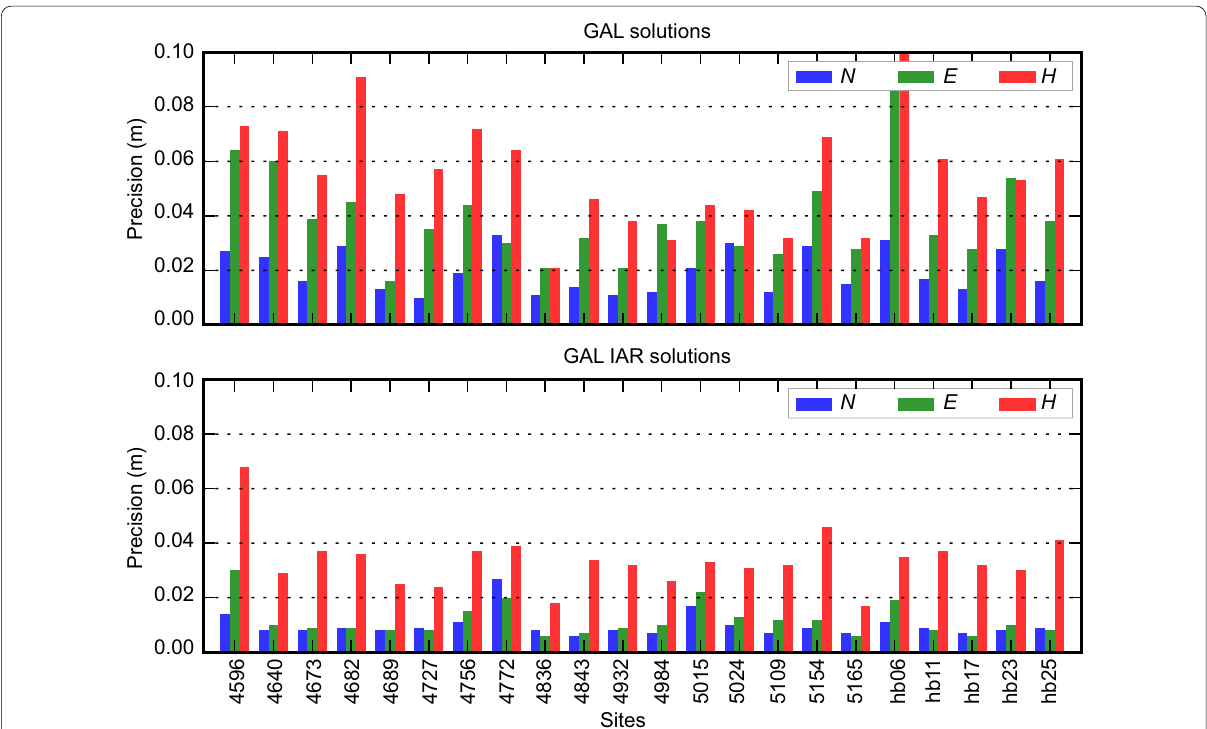
Table 1 Overall statistics of various solutions with different constellation or different combination of constellations. G - GPS, C - BeiDou, E - Galileo. The improvements are with respect to their corresponding ambiguity-float solutions Solutions STD (cm) Impr. (%) N E H